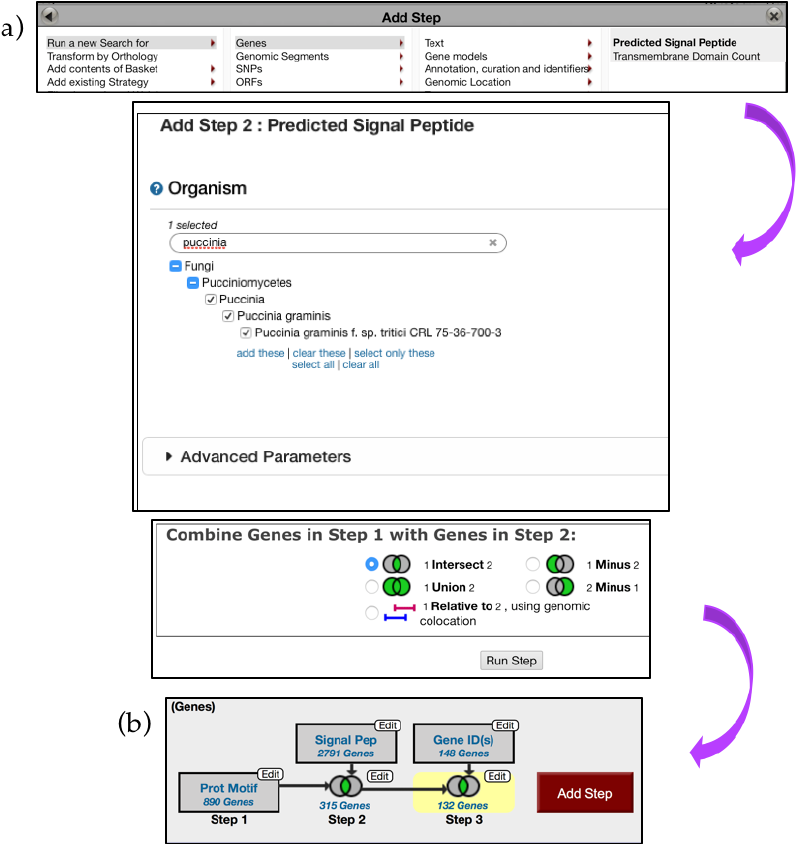
Figure 16. Identifying genes via the Motif Pattern tool, continued. ( a ) Predicted Signal Peptides search deployed via the Add Step function (Step 2) ( b ) Overview of the search strategy. Search results from